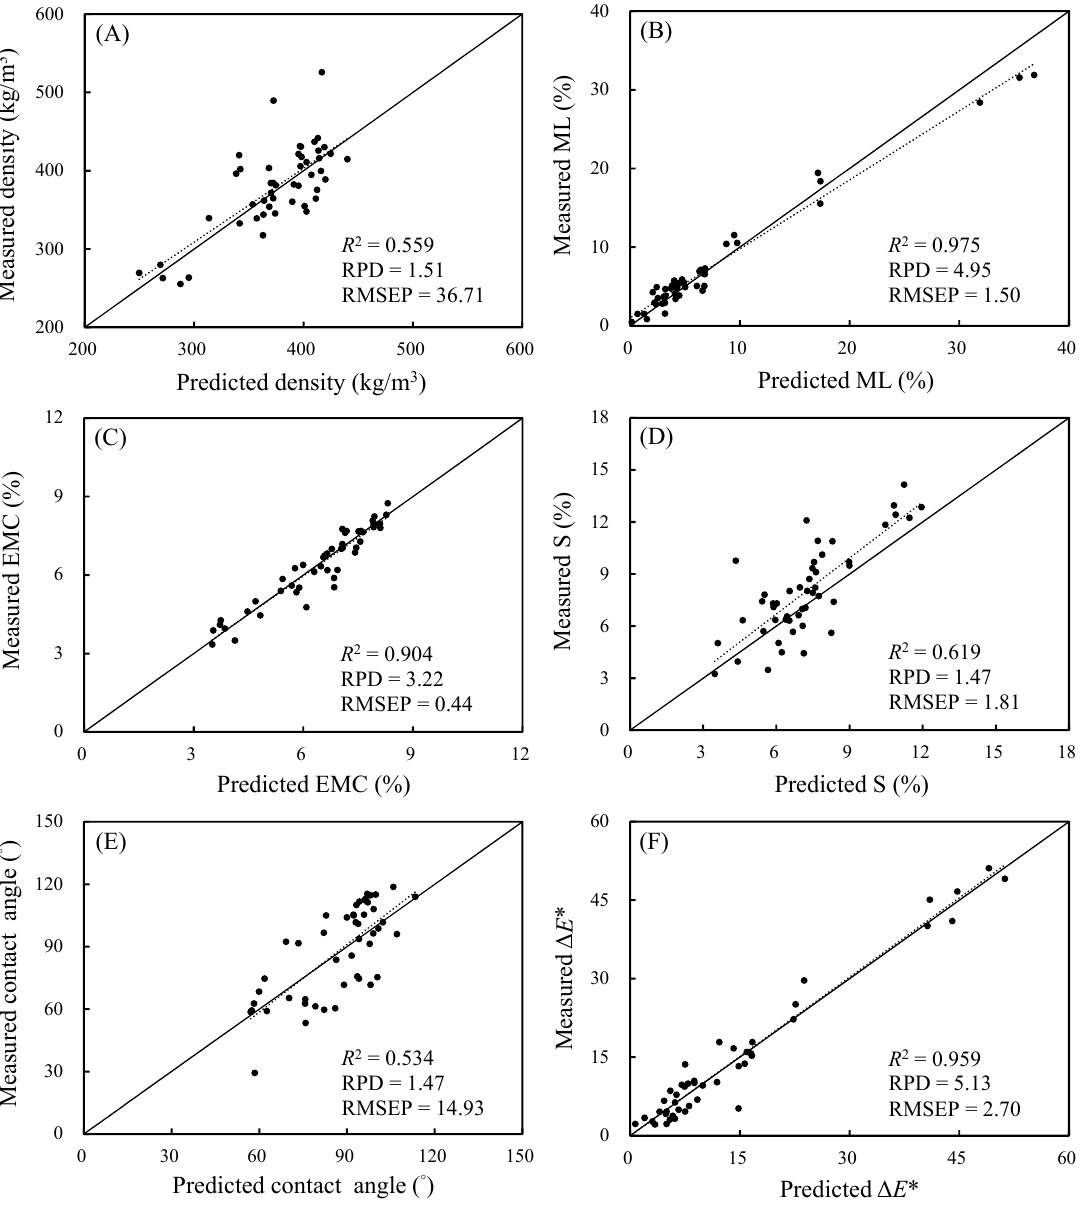
Figure 6. The correlation between predicted and measured values of air-dry density ( A ), ML ( B ), EMC ( C ), S ( D ), contact angle ( E ), and Δ E * ( F ) in prediction data.